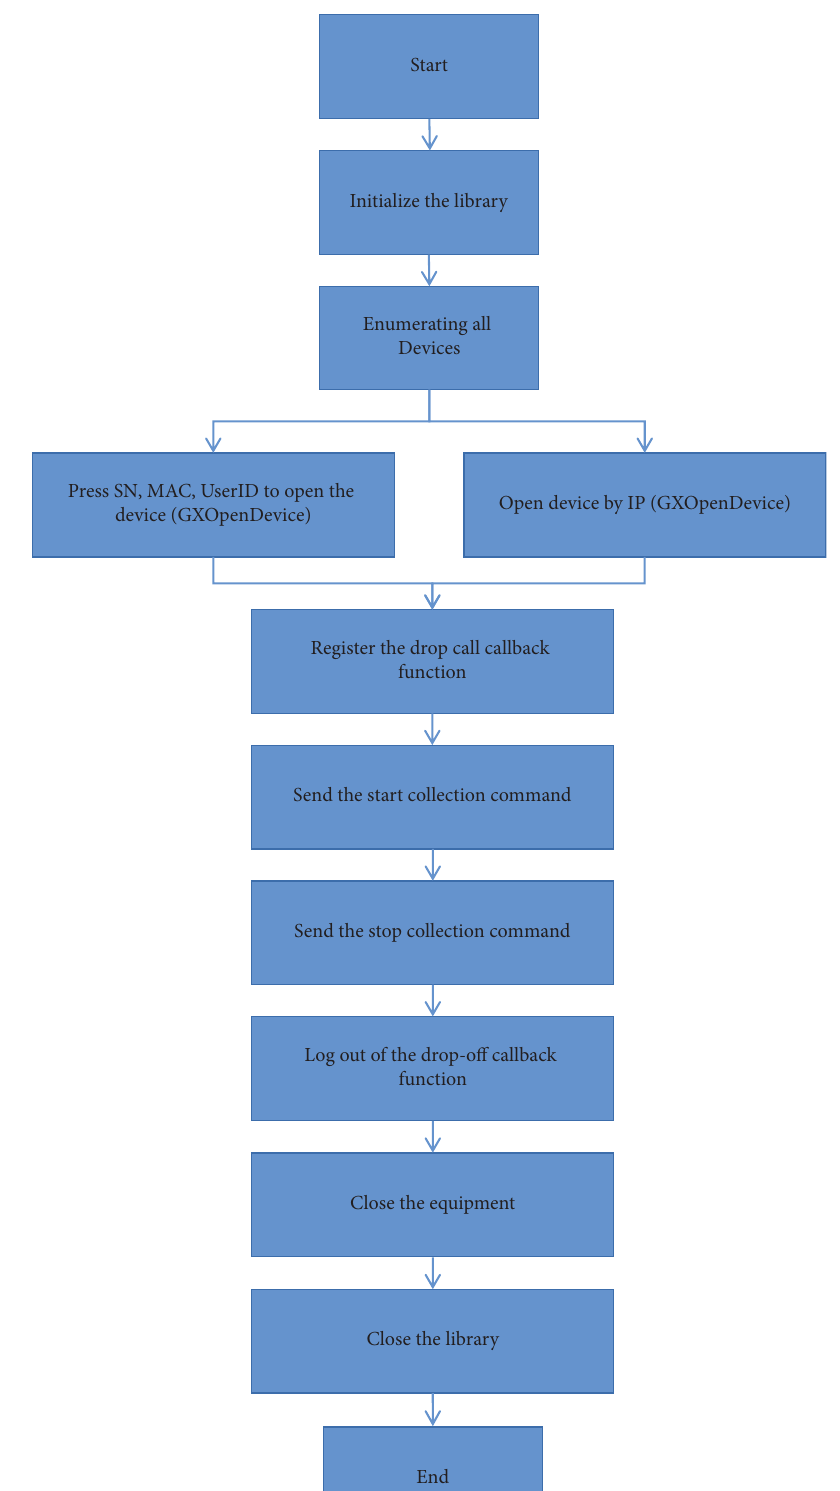
Figure 4: Overall workfow of mercury